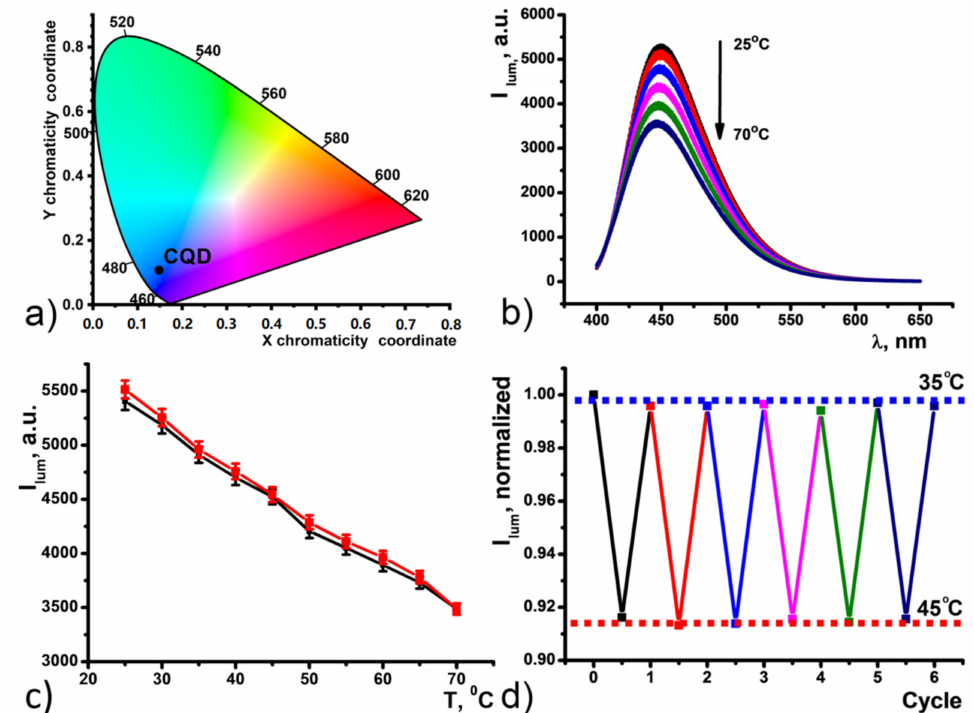
Figure 3. ( a ) Chromaticity diagram for CDs in H 2 O. ( b ) Temperature dependence of CDs emission upon heating. ( c ) Changes in the fluorescence intensity of the CDs ( λ ex = 360 nm) as a function of temperature under the heating (black) and cooling (red) over the 25–70 ◦ C range. ( d ) Normalized fluorescence intensity upon 6 heating-cooling cycles of CDs under an alternating temperature of 35 ◦ C and 45 ◦